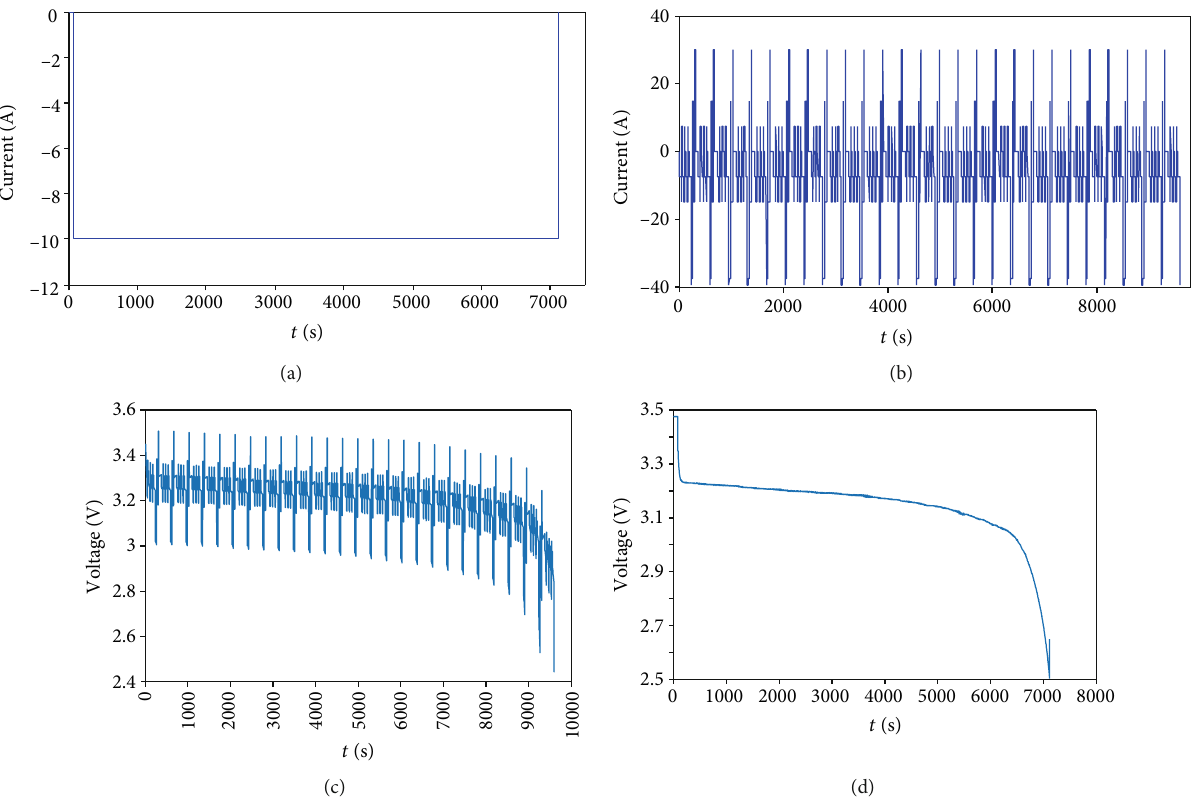
Figure 3: (a) Current waveform in experiment 1. (b) Current waveform in experiment 2. (c) Voltage waveform in experiment 1. (d) Voltage waveform in experiment